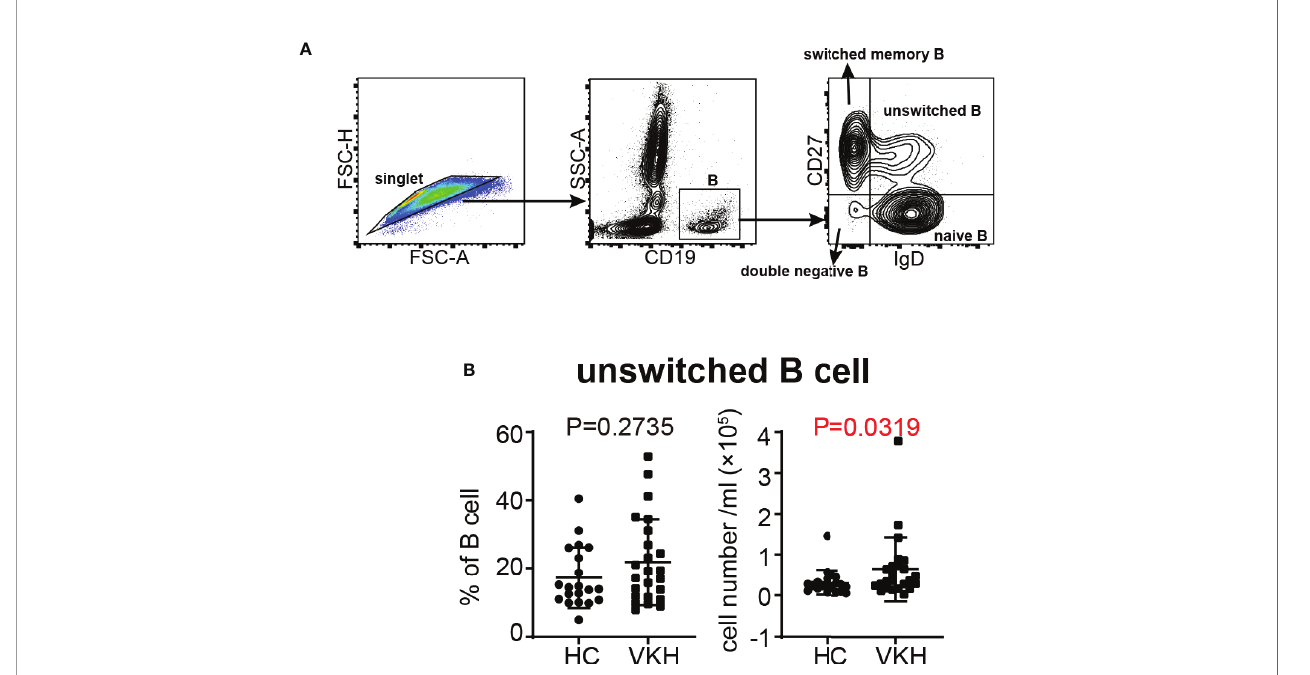
FIGURE 4 | Comparison of B cell subsets between VKH patients and healthy controls. (A) Gating strategy used for the characterization of B cell subsets. (B) The absolute number and proportion of unswitched B cells. Statistical analysis was performed using Mann – Whitney